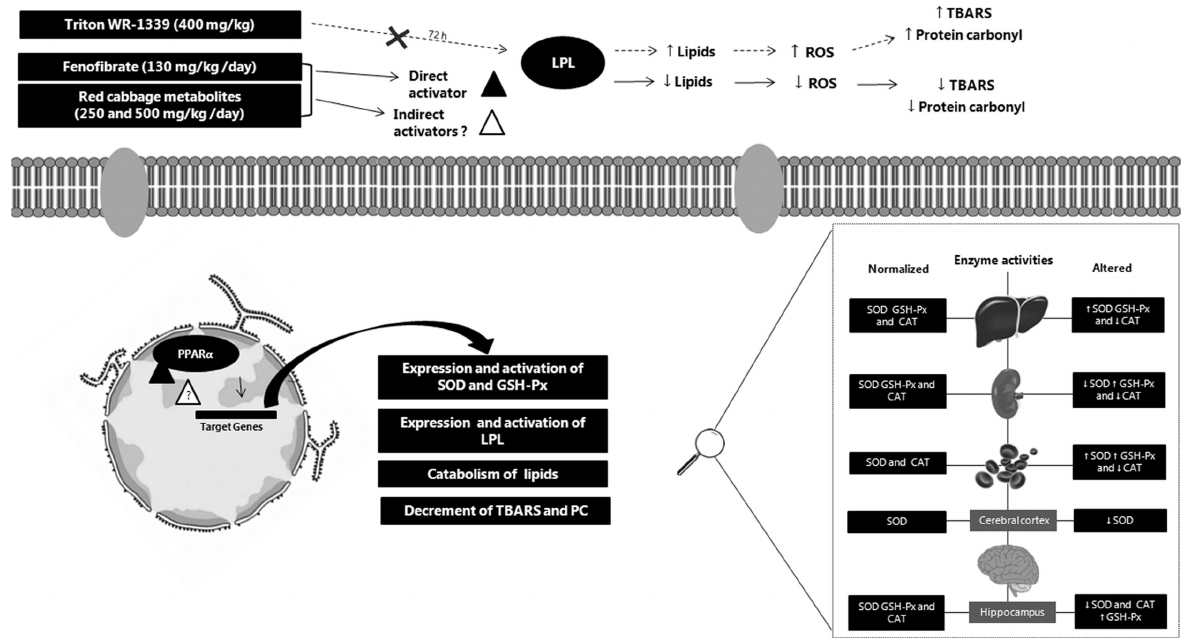
Figure 5. The schematic diagram shows biochemical pathways underlying Triton WR-1339-induced lipid oxidative stress and the antioxidant effects of RC and FF, a PPARα agonist. In this study, the RC and FF counteracted the alterations induced by Triton beyond the decrement of TBARS and PC levels normalizing the enzyme activities. CAT=catalase; FF= fenofibrate; GSH-Px= glutathione peroxidase; LPL= lipoprotein lipase; PPARα= Peroxisome proliferator-activated receptor alpha; PC= protein carbonyl; RC= red cabbage aqueous extract; SOD= superoxide dismutase; TBARS=thiobarbituric acid reactive